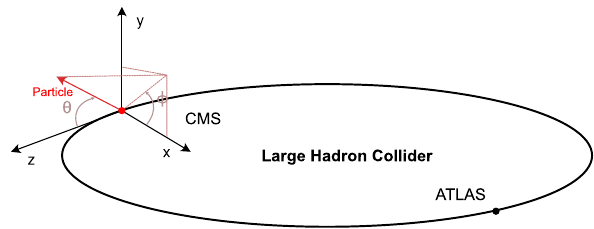
Fig. 1 Schematic representation of the right-handed Cartesian coordi- nate system adopted to describe the detector